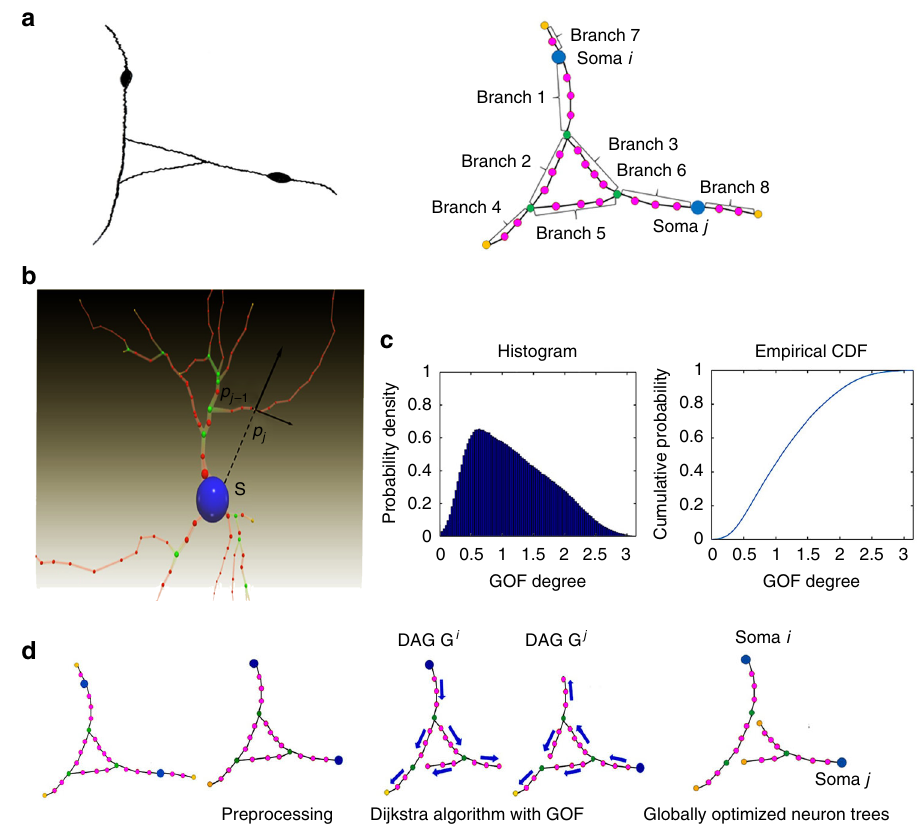
Fig. 2 G-Cut performs automatic segmentation based on biological features and graph theory. a The original graph representation of a neuron cluster consists of branches and somas. Each branch starts at one topological node, and ends at another topological node (soma nodes shown as blue, branch nodes shown as green, leaf nodes shown as yellow, path nodes shown as magenta, and edges between nodes shown as solid line). b The Growth Orientation Feature (GOF) quanti fi es the orientation of a branch with respect to a soma. Blue node: soma. Green node: branch node. Yellow node: leaf node. Red node: path node. c Left-hand panel shows an example histogram of the GOF for more than 70,000 experimentally reconstructed neuronal morphologies from the NeuroMorpho.Org database. Right-hand panel shows cumulative distribution function of the GOF derived from its histogram. d We identify bridging branches between somas and establish their topological relations by constructing a directed acyclic graph (DAG) rooted at a given soma using the Dijkstra algorithm. The branches which are reachable from only one soma are excluded with a Breadth- fi rst search algorithm in preprocessing to reduce problem size. The direction of each branch and its path from the soma are established in this step (direction of each branch shown as blue arrow). After that, the linear programming algorithm is used to fi nd a globally optimal segmentation for the neuron